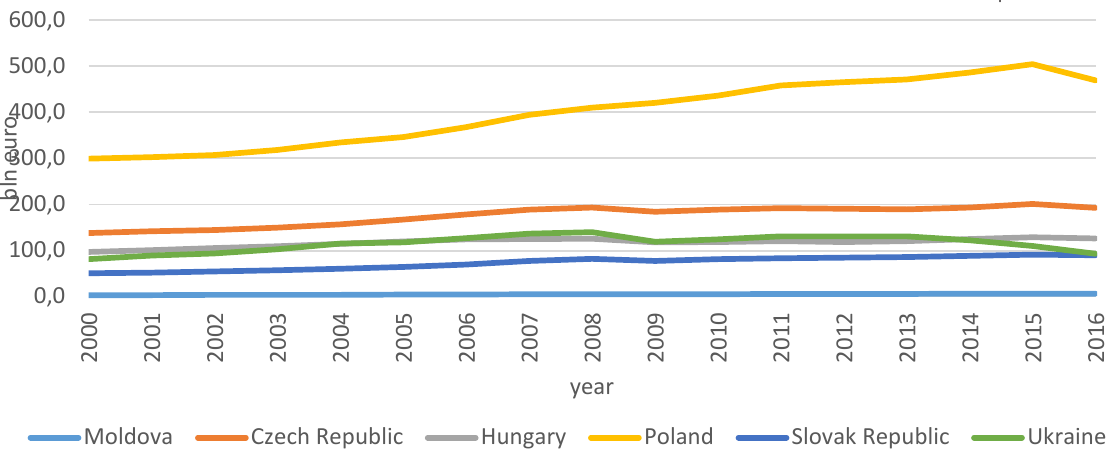
Figure 1. Dynamic of GDP in Ukraine, Moldova and Visegrad Group (2000–2016), bln. euro